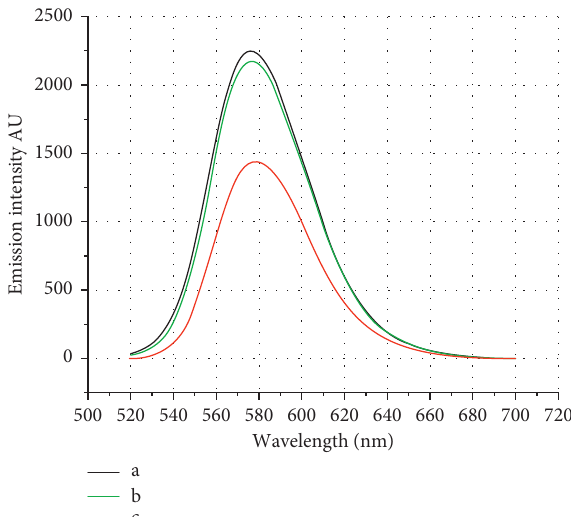
Figure 12: Emission spectra ( λ 10min (c).